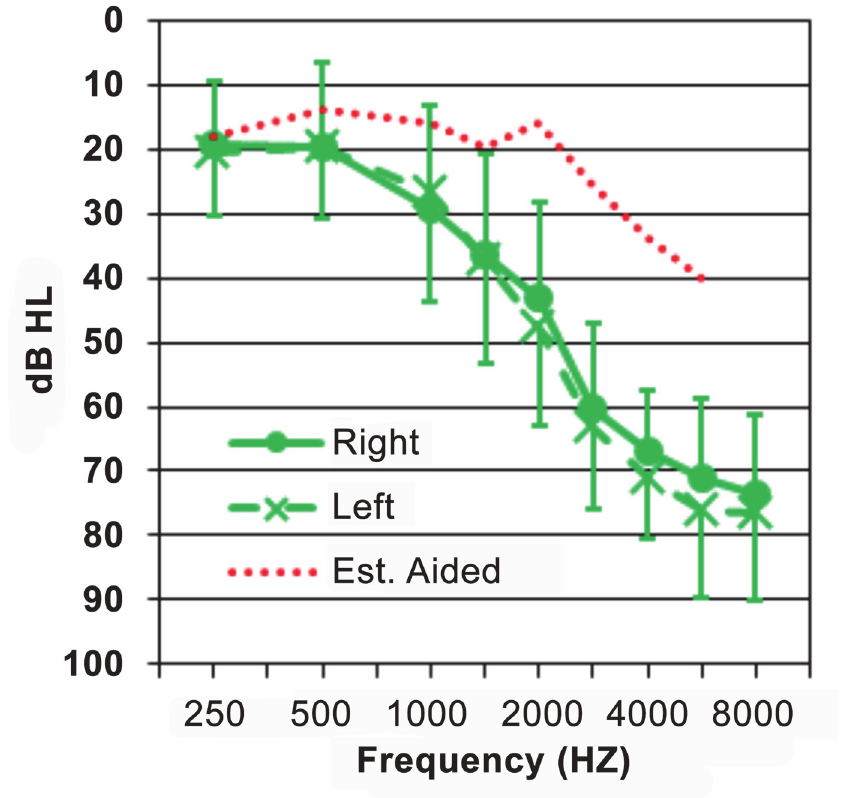
Fig 1. Average audiogram for the listeners who completed training and their average estimated aided thresholds based on HA prescriptive targets. Error bars show standard deviations.